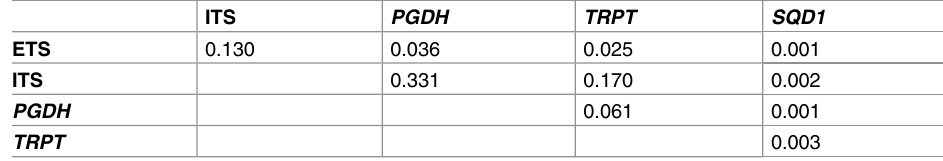
Table 2. P values of pairwise ILD tests for the nuclear ETS, ITS, PGDH , TRPT and SQD1 datasets.